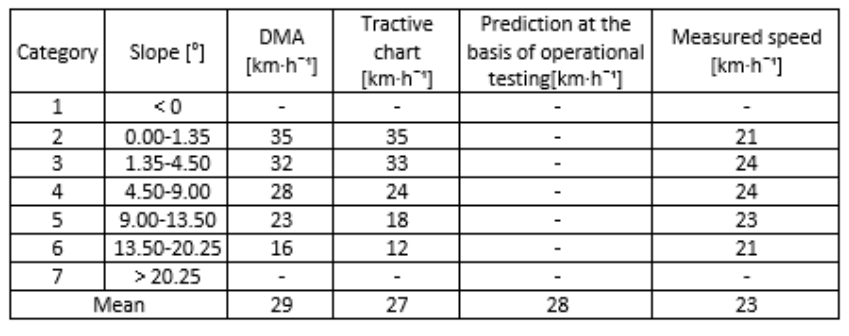
Tab. 3. The comparison of the calculated and measured